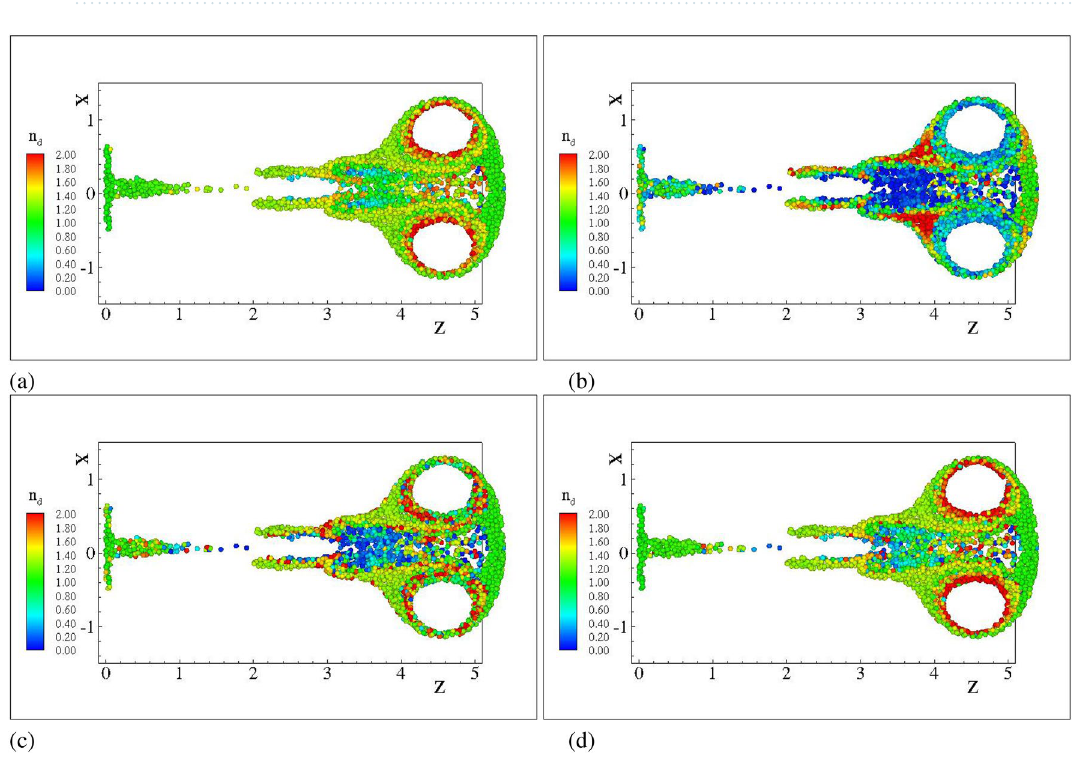
Figure 4. Number density for d = 5.0 µ m droplet nuclei. Case C2DN2. T = 4 ms ( a ) FLA ( b ) FLA2 R ε =